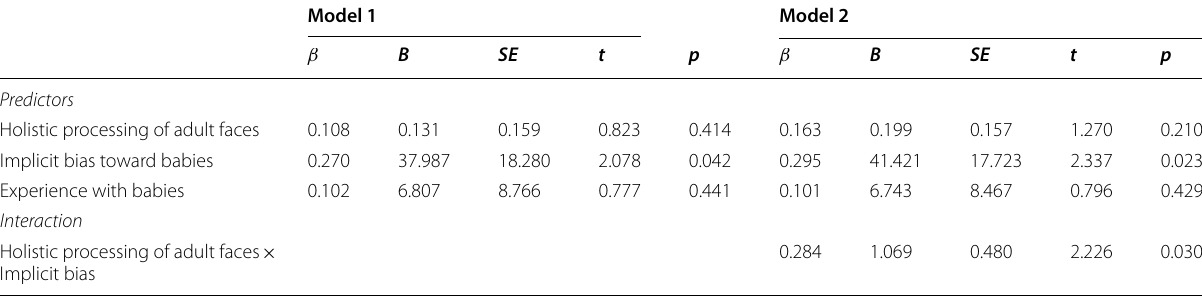
Table 10 Results of the multiple regression analyses on the congruency effect (∆RT: RT in incongruent trials minus RT in congruent trials) in Experiment